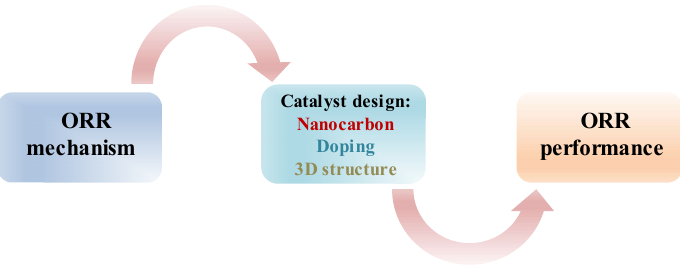
Figure 1. The relationships between ORR mechanism, catalyst design, and ORR performance.